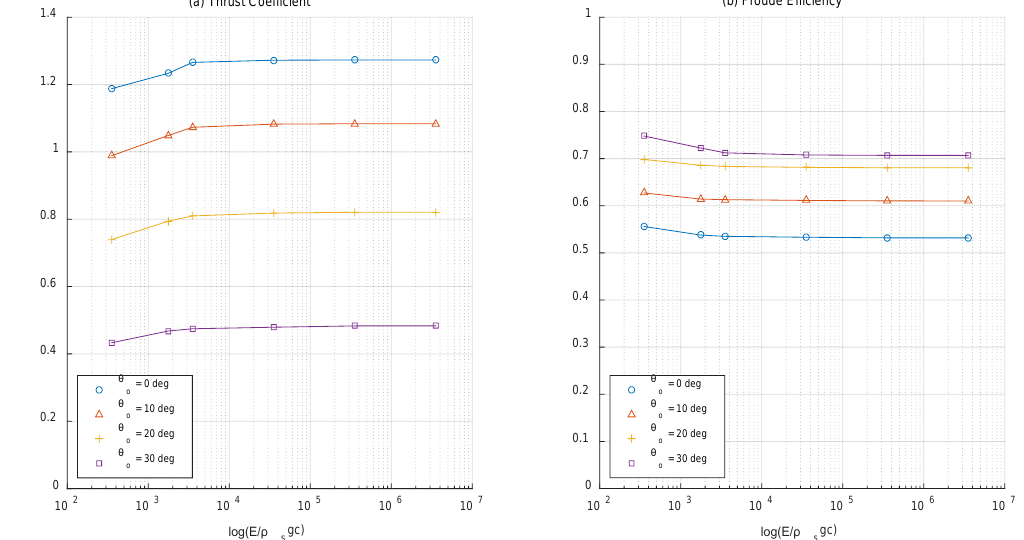
Figure 15. Propulsive performance of a chord-wise flexible NACA 0012 flapping foil in terms of the ( a ) thrust coefficient and ( b ) Froude efficiency as functions of Young’s modulus for the following parameters Str = 0.3, U = 0.4 m/s, h o / c = 0.75, ψ = 90 ◦ , x R = 1/3 c , c = 0.1 m.